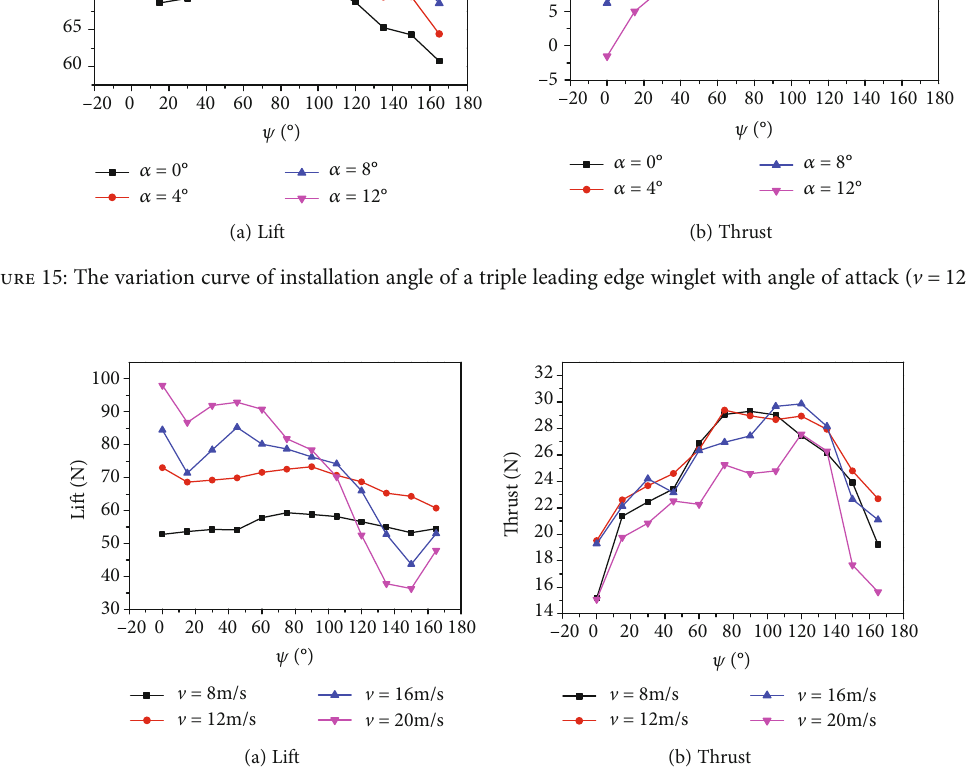
Figure 16: The variation curve of the installation angle of the triple leading edge winglet with the fl ow ( α = 0 °